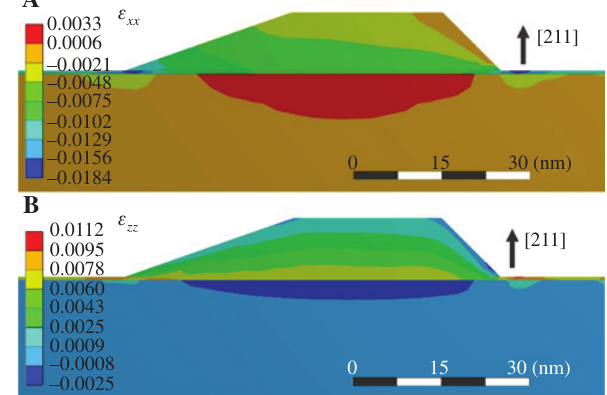
Figure 1: 3D schematic of a pyramidal anisotropic InAs QD, elon- gated along < 111 > direction. The QD is formed by the InAs wetting layer (WL) deposited on GaAs substrate, through the Stranski- Krastanov growth mode.